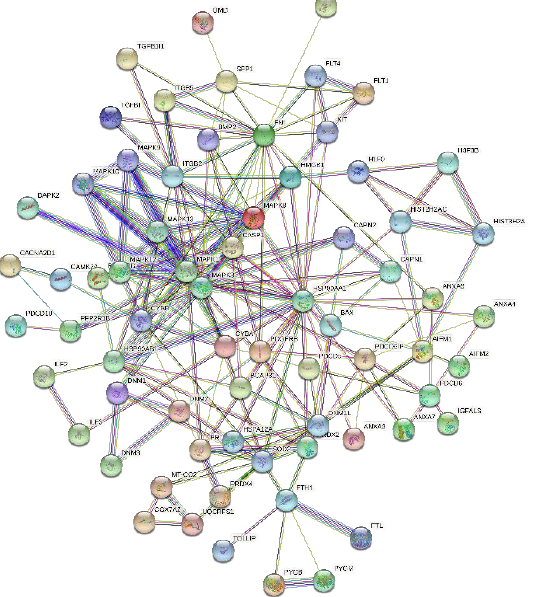
Figure 5. Protein–protein interaction (PPI) network from string analysis showing the tight network among growth factor proteins.